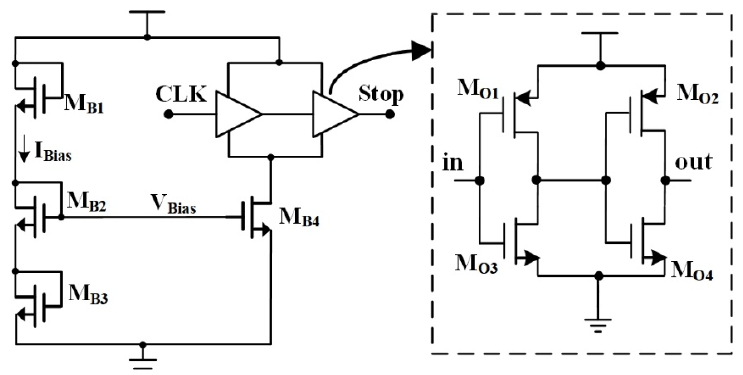
Figure 3. Structure of the offset compensator.